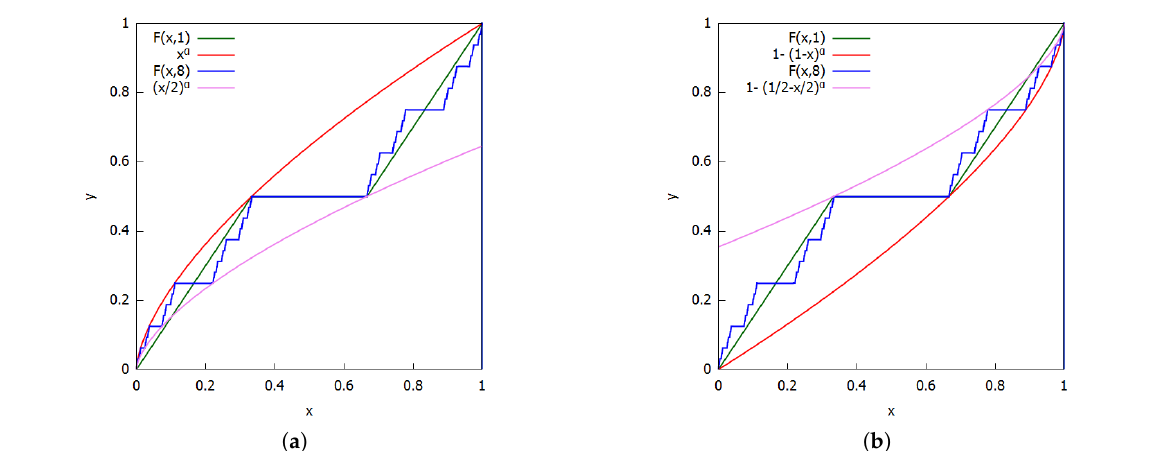
Figure 1. Recursive construction of Cantor’s function and its bounds. F ( x ) is approximated by an iteration function system, n = 8 iterations. ( a ) L ( x ) ≤ F ( x ) ≤ U ( x ) ; ( b ) 1 − U ( 1 − x ) ≤ F ( x ) ≤ 1 − L ( 1 − x )